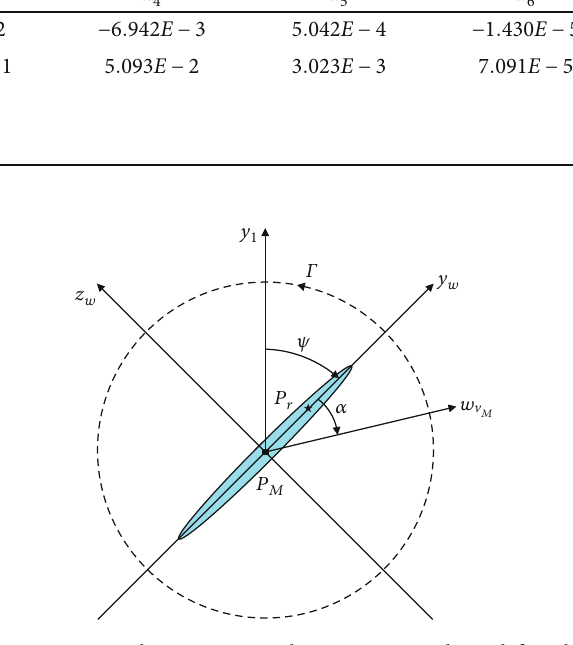
Figure 5: A single spanwise is taken as an example to de fi ne the circulation and angle of attack. The angle of attack is the angle between the velocity of the midpoint and the y spanwise strip; it varies between − π /2 and π /2 . The angle of attack in this case is